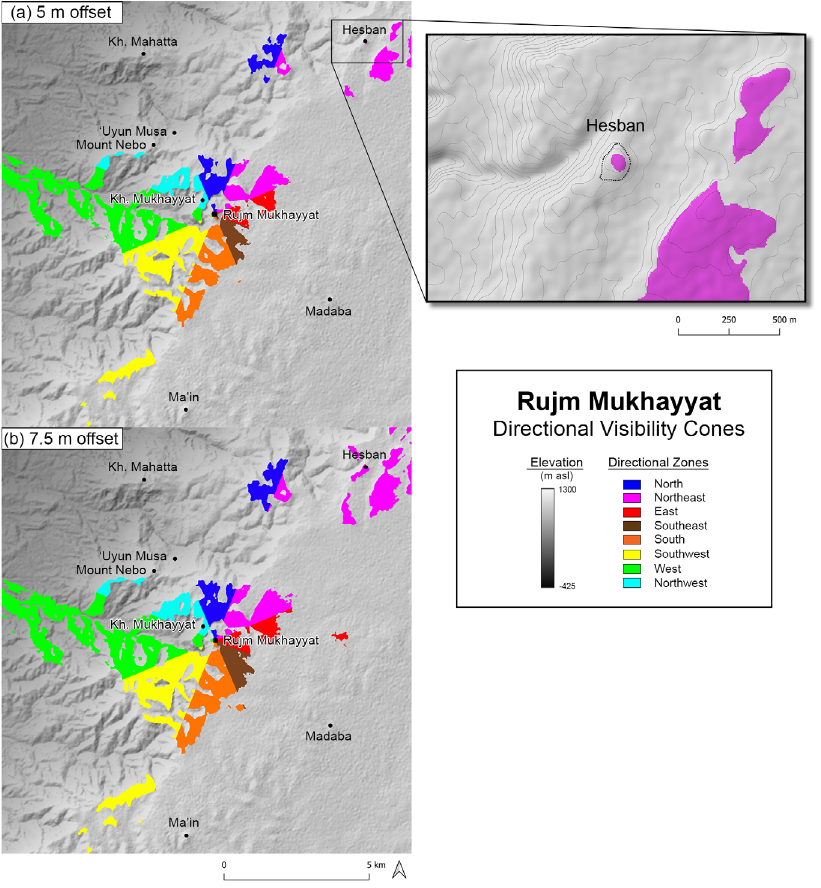
Figure 9: Map showing the directional visibility cones as measured from Rujm al-Mukhayyat using observer/target offsets of (a) 5 m and (b) 7.5 m. Panels show only a detail of the central region of the viewshed. For the full extent of the viewshed at the maximum observer/target offset, see Fig. 7(b). The inset at the top right shows a detail view of Hesban, which is just visible from Rujm Mukhayyat at an observer/target offset of 5